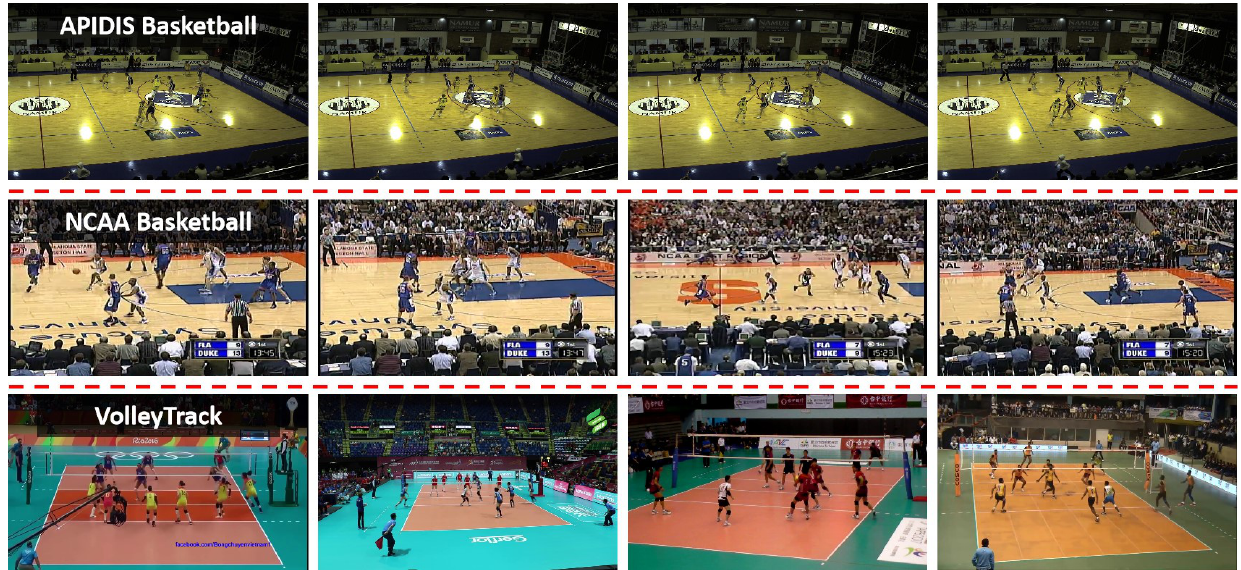
Figure 6. Example frames of the APIDIS, NCAA basketball and VolleyTrack databases (each row belongs to a